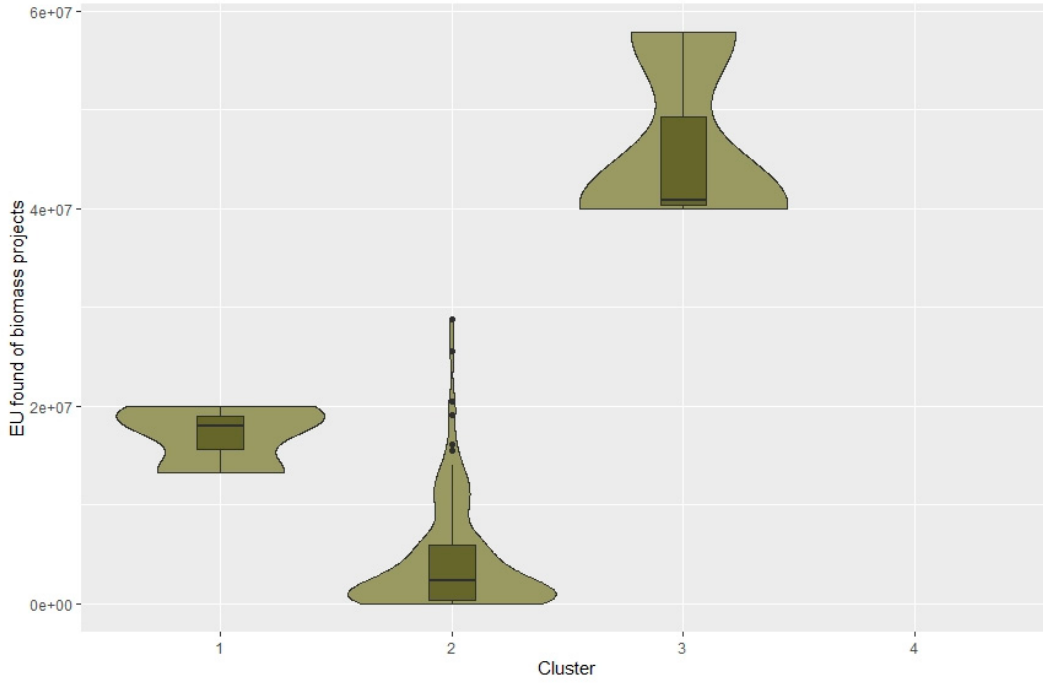
Figure A9. Violin plots for EU funds of biomass projects in clusters, cluster 4–no projects.